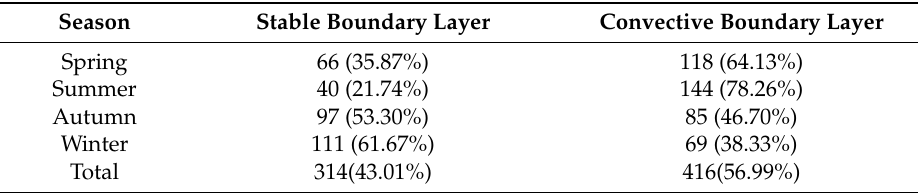
Table 2. Number and percentage of samples of stable and convective boundary layers for different seasons during